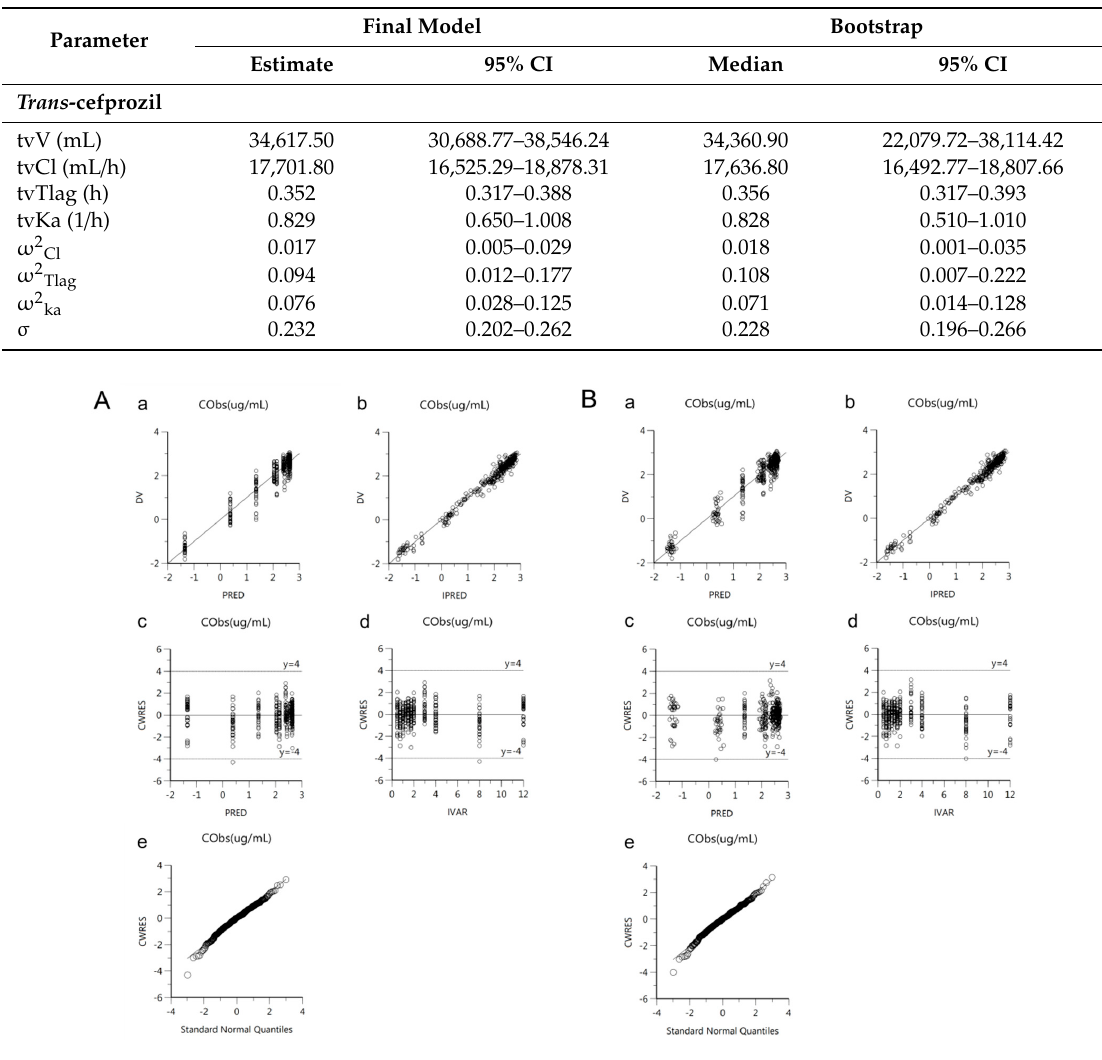
Figure 4. Goodness-of-fit plots of base model ( A ) and final model ( B ) for total cefprozil. ( a ) Observed plasma concentrations (DV) against population predicted concentrations (PRED); ( b ) Observed plasma concentrations (DV) against individual predicted concentrations (IPRED); ( c ) Conditional weighted residuals (CWRES) against population predicted concentration (PRED); ( d ) Conditional weighted residuals (CWRES) against time (IVAR); ( e ) Quantile-quantile plot of components of conditional weighted